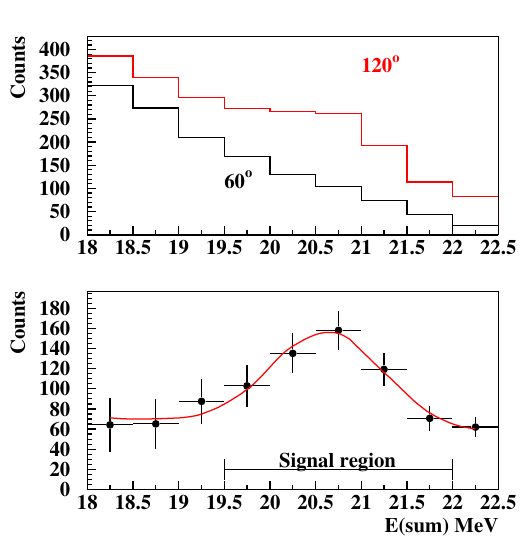
Figure 5. Angular correlation for e + e − pairs detected from the 21 MeV 4 He transition. The background, taken from outside the signal region, is shown in black dots, with error bars. A fourth order exponential polynomial is used to fit the background. The result is shown with a solid blue line. The result for the signal region is seen in red asterisks, with error bars. The solid green curve shows simulation results, which take the decay of the X17 boson into